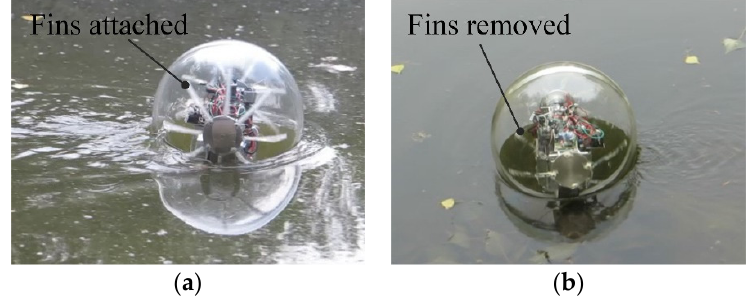
Figure 11. Movement on the water. ( a ) Fins attached; ( b ) Fins removed.